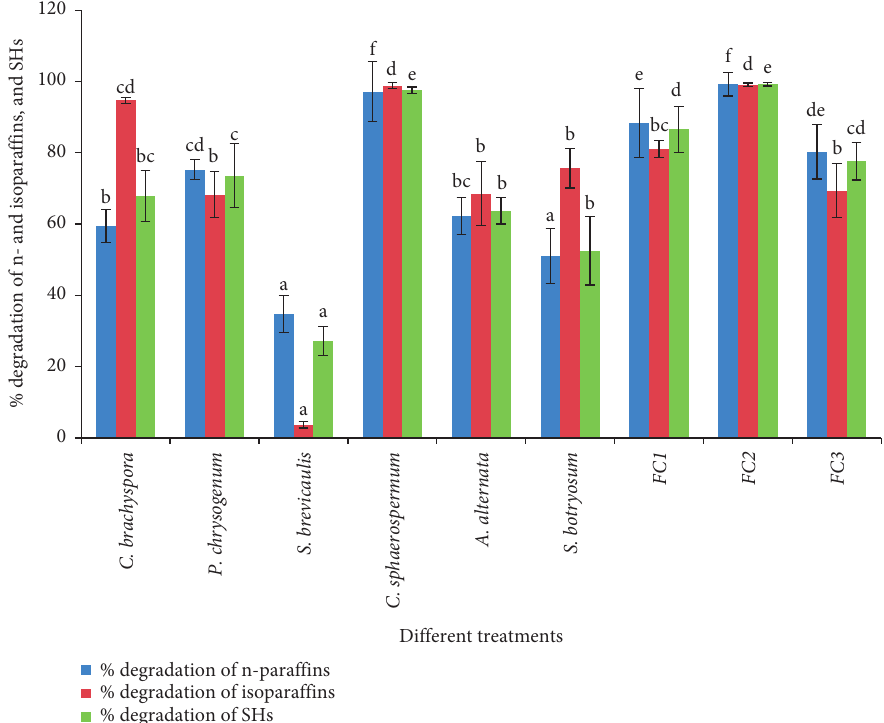
Figure 4: % degradation of n-paraffins, isoparaffins, and total SHs, estimated by GC, upon using pure and mixed fungal cultures cor- responding to untreated control. SE is presented as a vertical bar above each mean. The same letters indicate that there is no significant difference in % degradation (of n-paraffin, isoparaffin, and SHs) in samples treated with different pure and mixed fungal cultures regarding Duncan’s multiple range tests at P < 0.05. FC1 = mixed culture of Penicillium chrysogenum and Curvularia brachyspora , FC2 = mixed culture of Scopulariopsis brevicaulis and Stemphylium botryosum , and FC3 = mixed culture of Scopulariopsis brevicaulis , Stemphylium botryosum, and Cladosporium sphaerospermum . Table 2: Changes in the mixture of PAHs (mg/l), estimated by HPLC, for samples treated with six fungal species corresponding to untreated control. Nap � naphthalene, A � acenaphthylene, Ace � acenaphthene, F � fluorene, Phe � phenanthrene, Ant � anthracene, Flu �